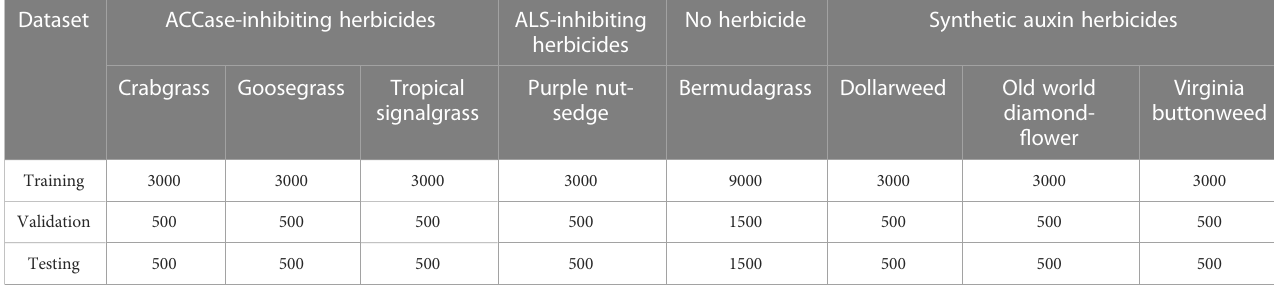
TABLE 1 The number of sub-images used to establish the training, validation, and testing datasets of the convolutional neural networks. Dataset